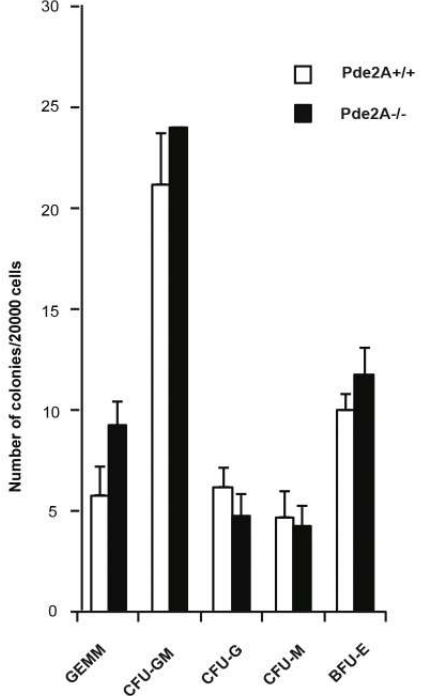
Figure 6. The maturation potential of hematopoietic progenitor/stem cells is preserved in PDE2A − / − embryos. Colony-Forming-Cell (CFC) assay identifies an equivalent number of colonies in cells isolated from E14.5 PDE2A + / + and PDE2A − / − livers. The different types of colonies are labeled as follows: GEMM colony forming unit granulocyte-erythrocyte-megakaryocyte-monocyte; CFU-GM granulocyte-monocyte; CFU-G granulocyte; CFU-M monocyte; BFU-E Burst forming unit erythroid. At least N = 3 embryos/genotype were analyzed in each experiment in triplicates.